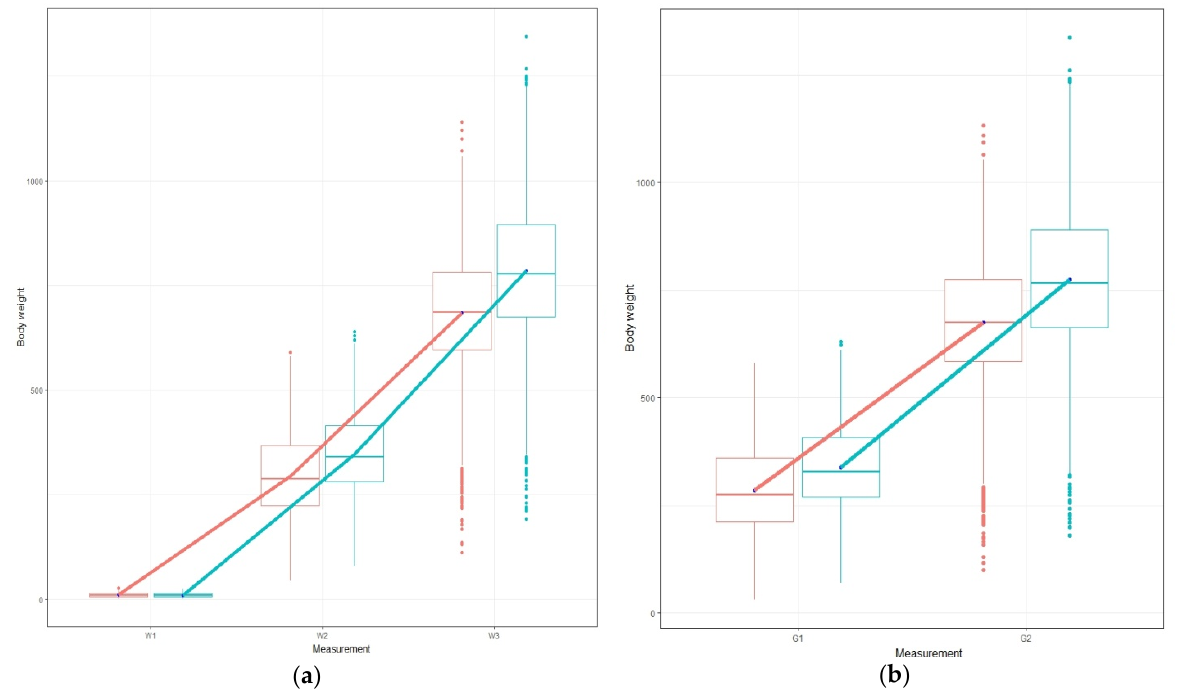
Figure 1. Plots of the body weight performance for the total population, ( a ) and ( b ) illustrate the body weight and the growth, respectively. The red line corresponds to plant-based diet and the blue line corresponds to standard commercial diet.